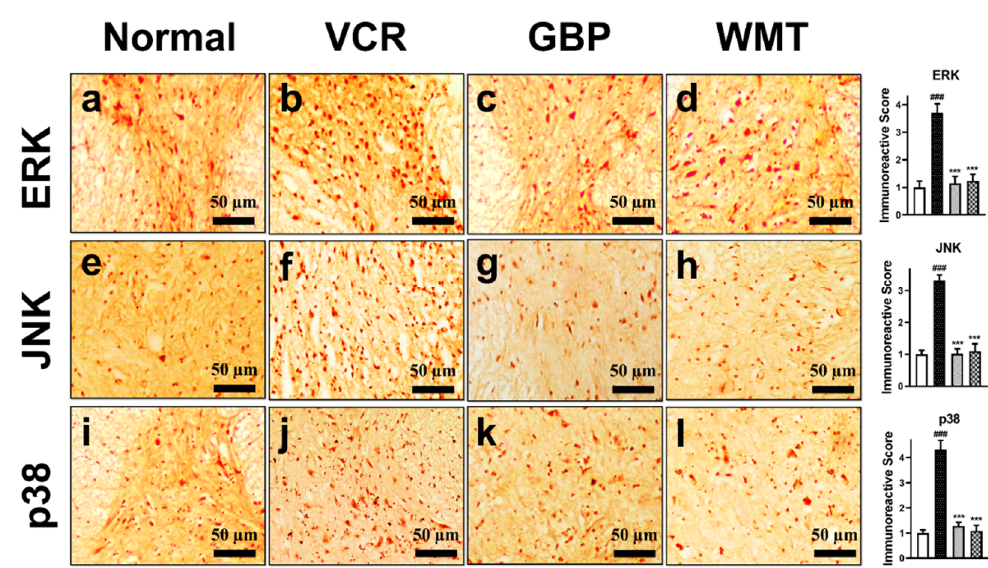
Figure 13. Effect of the withametelin treatment on the expression levels of the ERK/JNK/p38 proteins in the mouse spinal cords. Magnification 10×. ERK ( a – d ), JNK ( e – h ), and p38 ( i – l ). All the results were expressed as the mean ( n = 3) ± SD. ### p < 0.001 vs. the control group. *** p < 0.001 vs. the VCR group.